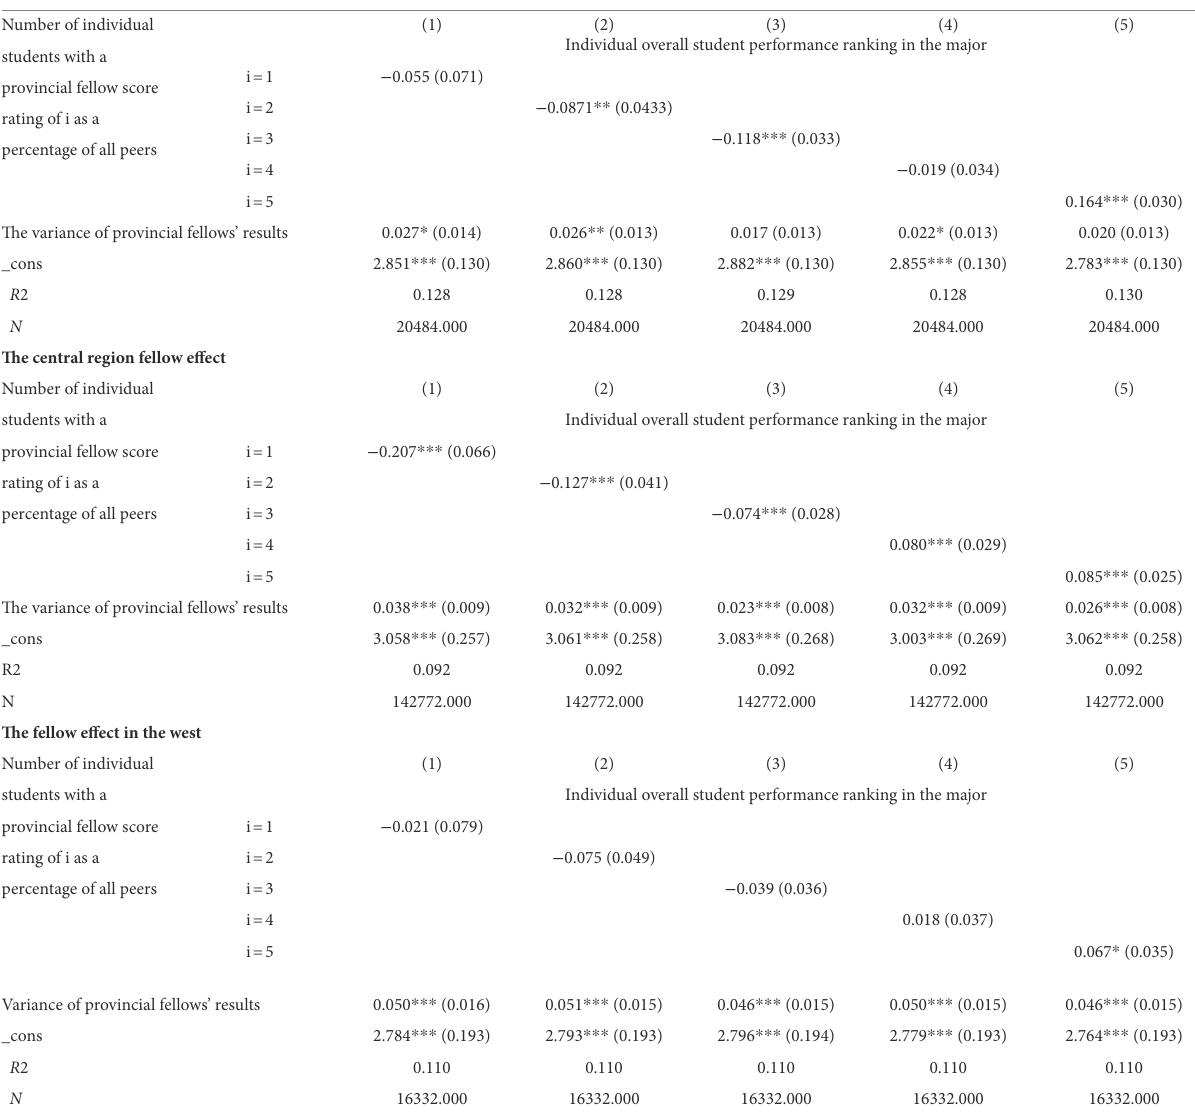
TABLE 5 Fellow effect in east, central and west